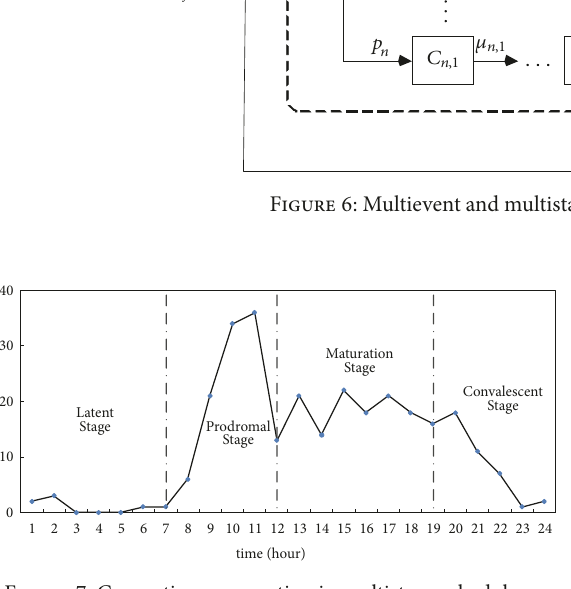
Figure 7: Congestion propagation in multistage